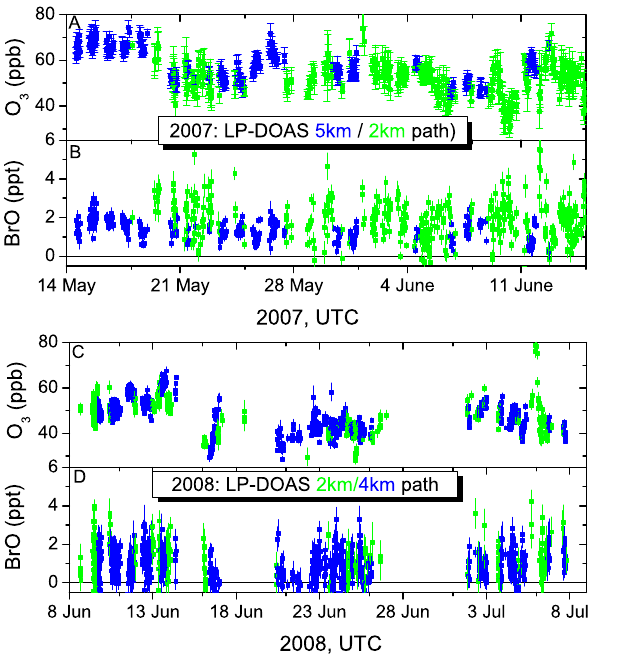
Fig. 3. Overview of the 2007 and 2008 GSHOx BrO and ozone data measured by the LP-DOAS on either the 2km (green) or 5km/4km (blue) light paths. A laser aiming system used in 2008 resulted in longer periods of measurements in 2008 vs. 2007. In both years storms with high wind speeds and nocturnal fog resulted in periods without data.